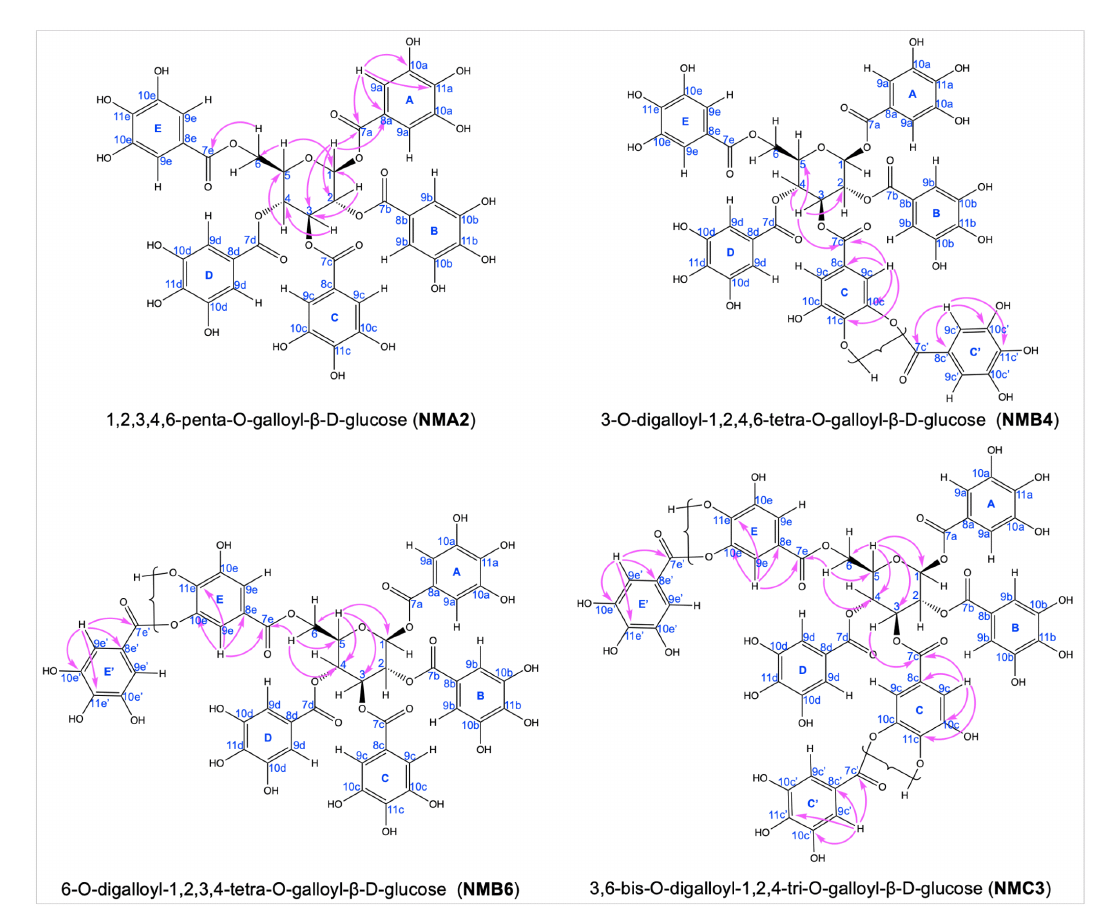
Figure 2. Structures of isolated compounds with annotations of selected HMBC correlations. Table 1. 1 H and 13 C chemical shifts and HMBC correlations for compounds NMA2 and NMB4 (600 MHz). Chemical shifts of the same compounds previously reported in the literature are shown in square